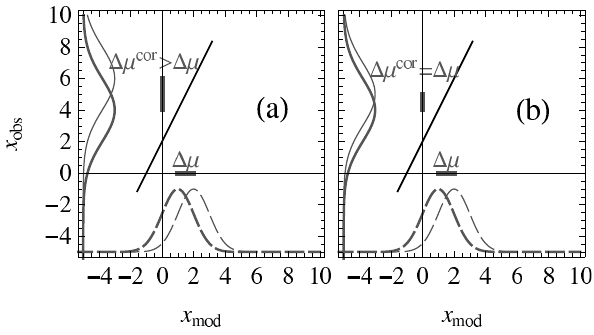
Fig. 1. Two possible options for performing a statistical bias correction on the distribution of the variable x in arbitrary units; Heavy (thin) lines are control (scenario) period data; Solid (dashed) lines are observed (modeled) data; solid straight line represents the linear transfer function. Note that in (a) the climate change signal is enhanced by applying the bias correction ( 1µ cor >1µ ) while in (b) it is not ( 1µ cor = 1µ To define the TF, one could equally well choose other fluctuations instead of daily fluctuations, for example seasonal fluctuations. In the case of temperature, seasonal fluctuation, similar to diurnal 110 fluctuations, are caused - directly or indirectly - by the changes in the solar radiance and could be seen as a response of the system to such changes in the energy budget. However, climate change is usually assumed to be due to changes in boundary conditions, which bring about the greenhouse 4